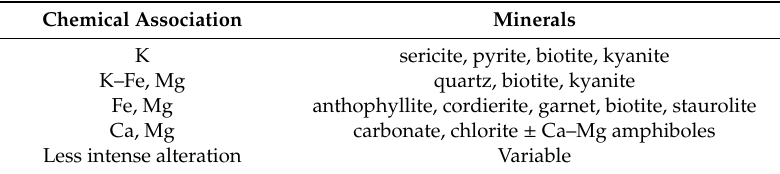
Table 1. Chemical associations di ff erentiated in the footwall hydrothermal alteration zone of the Lalor VMS deposit after